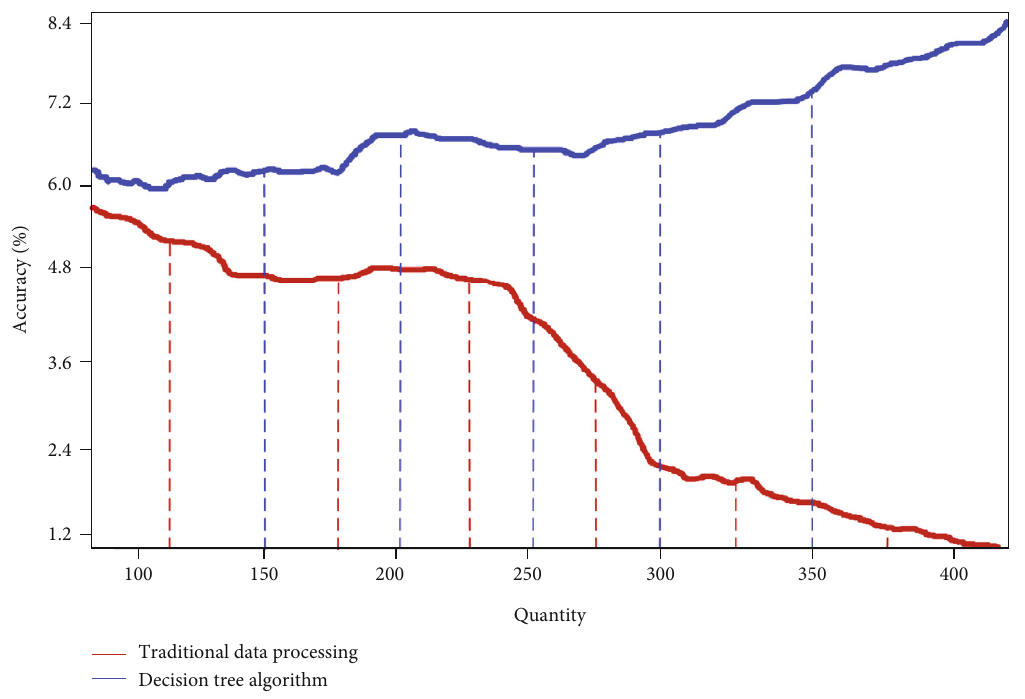
Figure 6: Accuracy comparison between traditional method and decision tree algorithm. Table 1: Student evaluation information